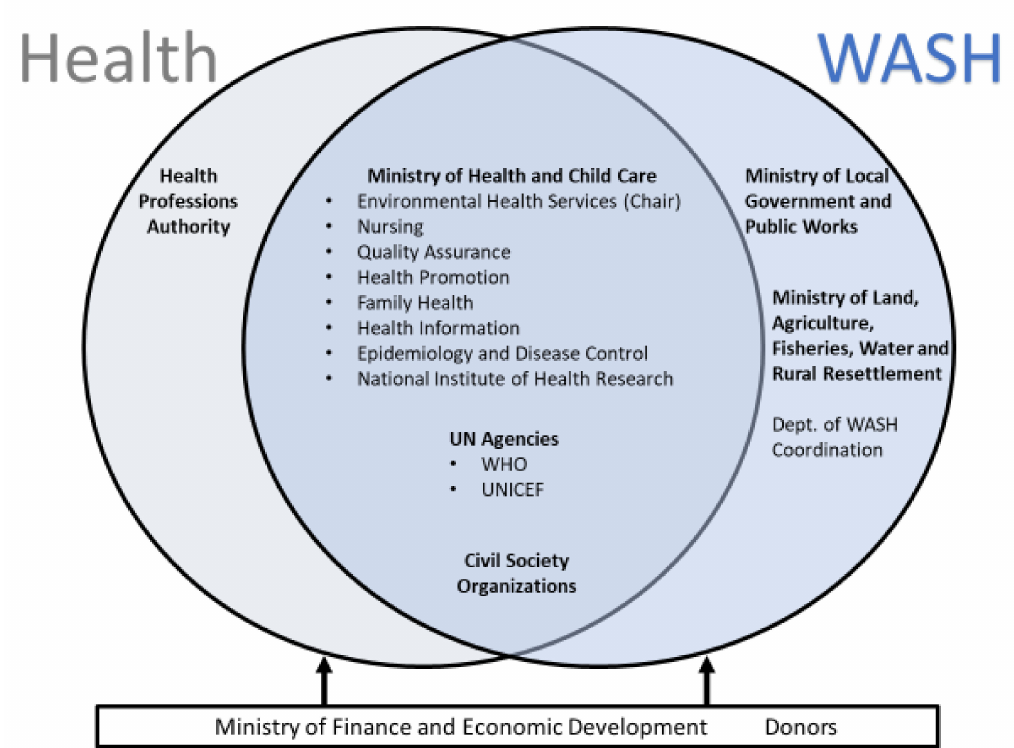
Figure 1. WASH in Healthcare Facilities Taskforce Members in Zimbabwe. In 2020, the COVID-19 pandemic highlighted the importance and urgency of enhanc- ing WASH coverage in HCFs [17]. Globally, over 166.7 million cases and 3.4 million deaths were reported as of 23 May 2021 [18]. Zimbabwe has recorded a total of 38,679 cases